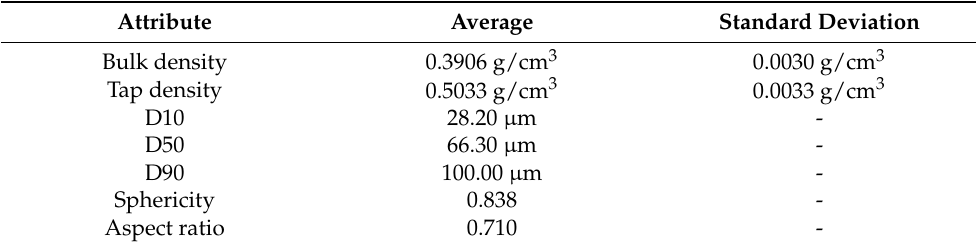
Figure 1. Particle size distribution of the used sinter material. The analysis of the particle size distribution includes the frequency of occurrence over the respective particle size, which is shown on the x -axis. Determined with Camsizer XT. Table 1. Characteristics of the investigated sinter material.